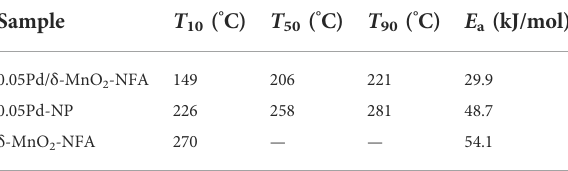
TABLE 1 Values of T 10 , T 50 , T 90 , and E a for toluene oxidation.